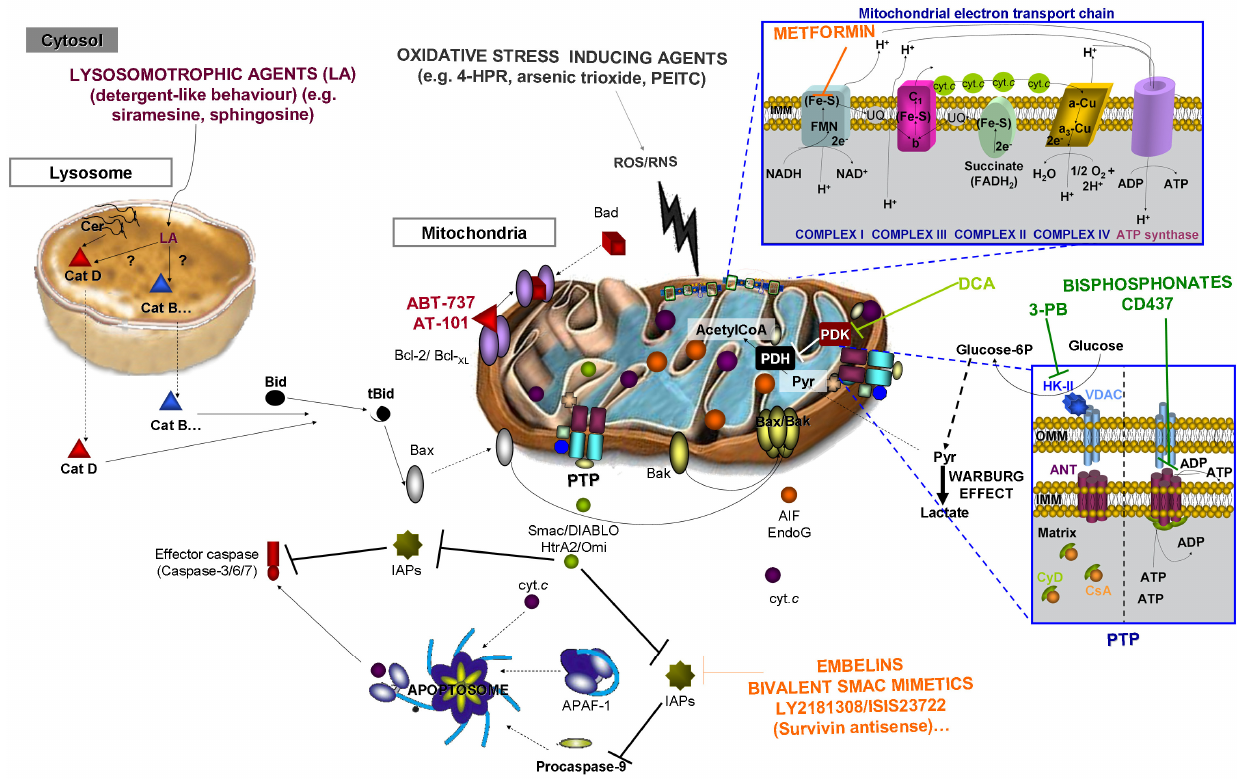
Figure 6. Drugs targeting mitochondrion or lysosome. The figure represents an overview of compounds aimed to induce tumor cell death by interacting with specific molecules (as shown in the figure), by inducing oxidative damage or permeabilization of the lysosomal